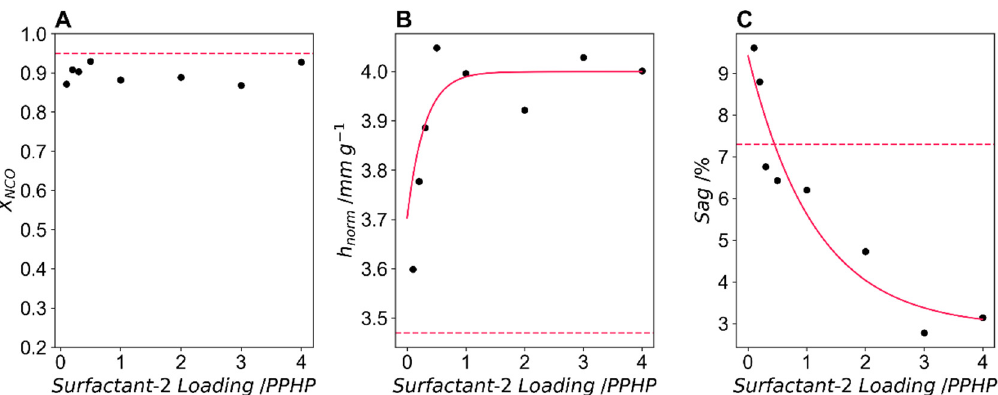
Figure 6. ( A ) Isocyanate conversion as a function of surfactant-2 loading, the dashed line indicates the predicted conversion at the constant catalyst loading. ( B ) The normalised maximum height (height divided by foam mass) of the foam as a function of surfactant-2 loading with the dashed line indicating the normalised height with no surfactant-2 and the solid line an exponential fit to the data. ( C ) The foam sag in percent as a function of surfactant-2 loading with the dashed line indicating the sag of a formulation with no surfactant-2 and the solid line an exponential fit to the data.